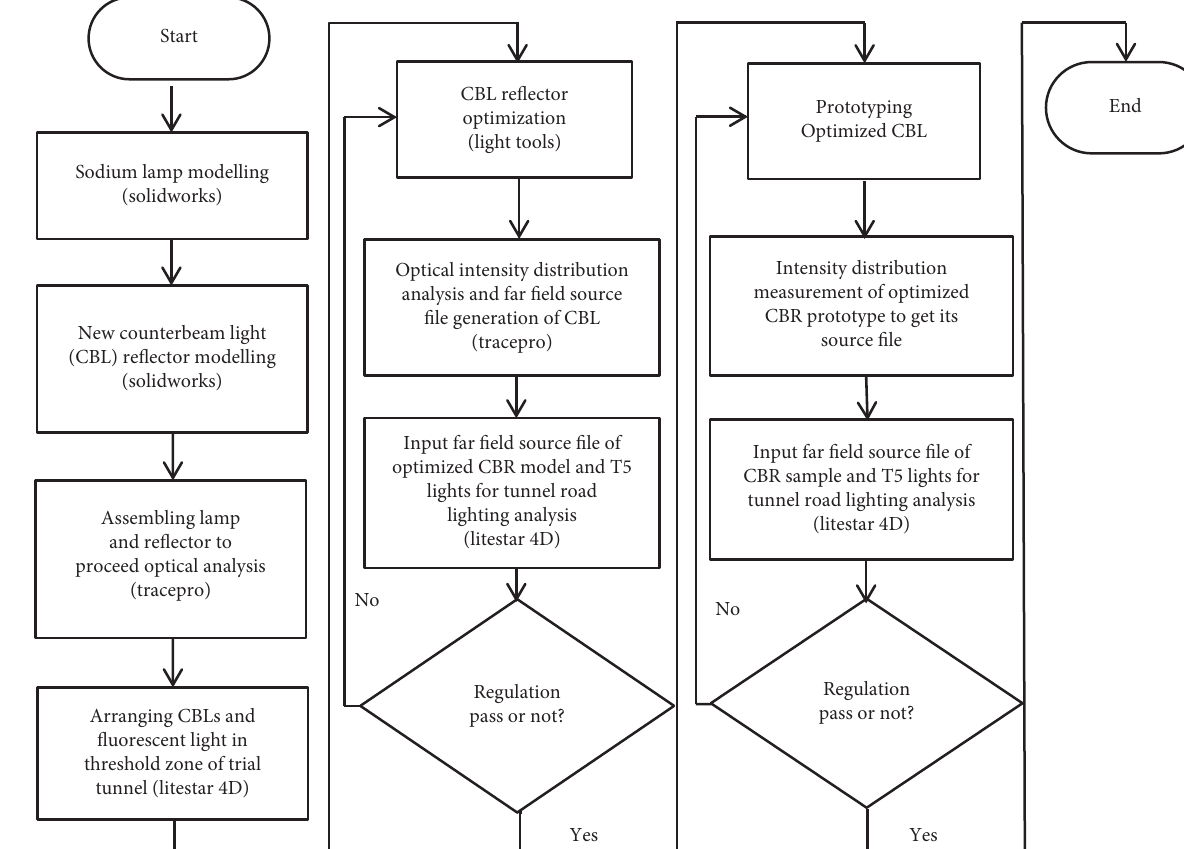
Figure 7: The workflow of optimizing counter beam light to accomplish CIE 88 :2004 tunnel lighting design.